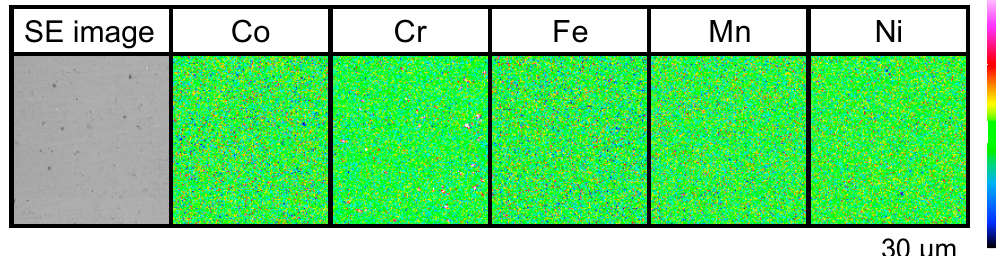
Figure 5. SE image and electron-probe microanalysis (EPMA) elemental mapping images of Co, Cr, Fe, Mn, and Ni for the SPS sample sintered for 10 min at 1173 K.